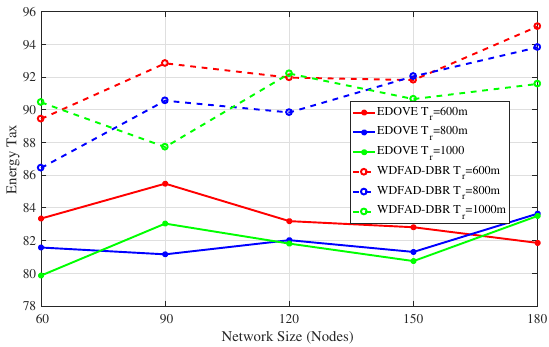
Figure 12. Energy Tax of the network versus the network sizes.